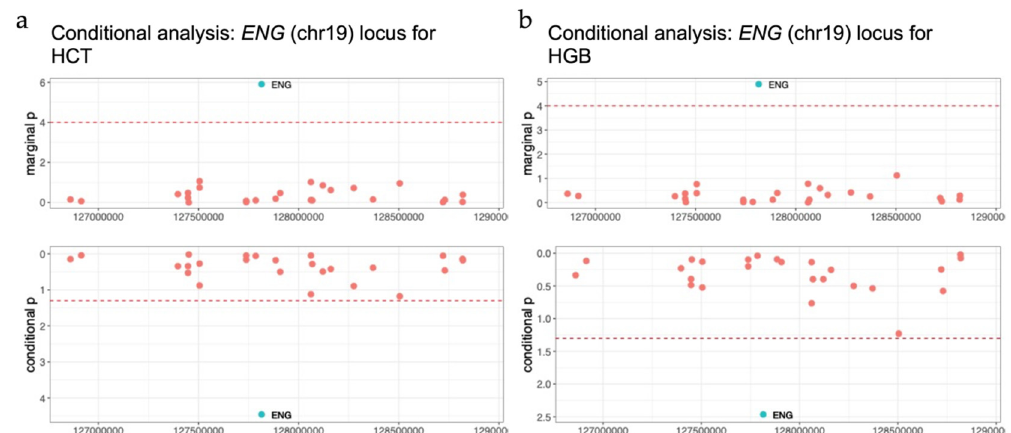
Figure 7. ENG locus. ( a ) The marginal and conditional results for ENG for hematocrit (HCT) and ( b ) hemoglobin (HGB) predicted using the Multi-Ethnic Study of Atherosclerosis (MESA) reference panel in African ancestry (AA) meta-analysis. The green dot denotes the gene ENG , the red dots denote other genes within this locus region.